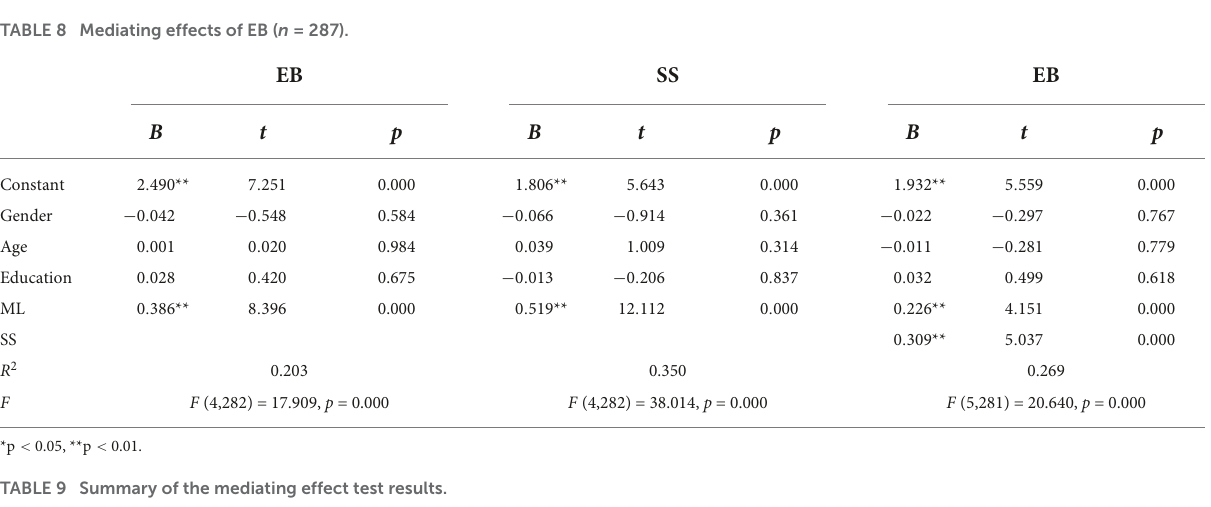
TABLE 9 Summary of the mediating effect test